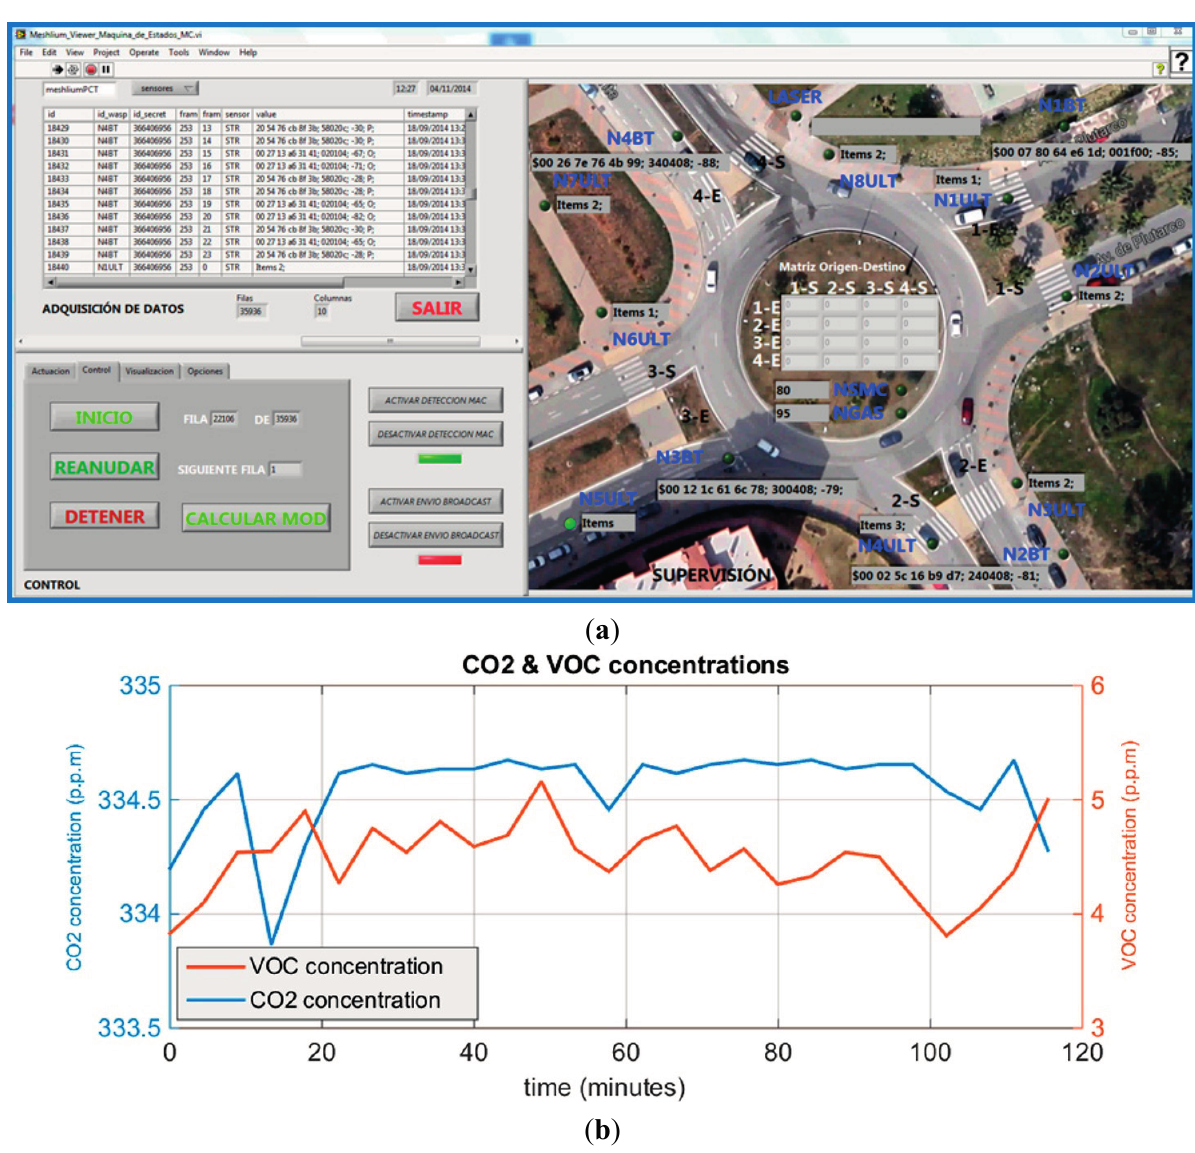
Figure 13. ( a ) SCADA; ( b ) Historical graph for